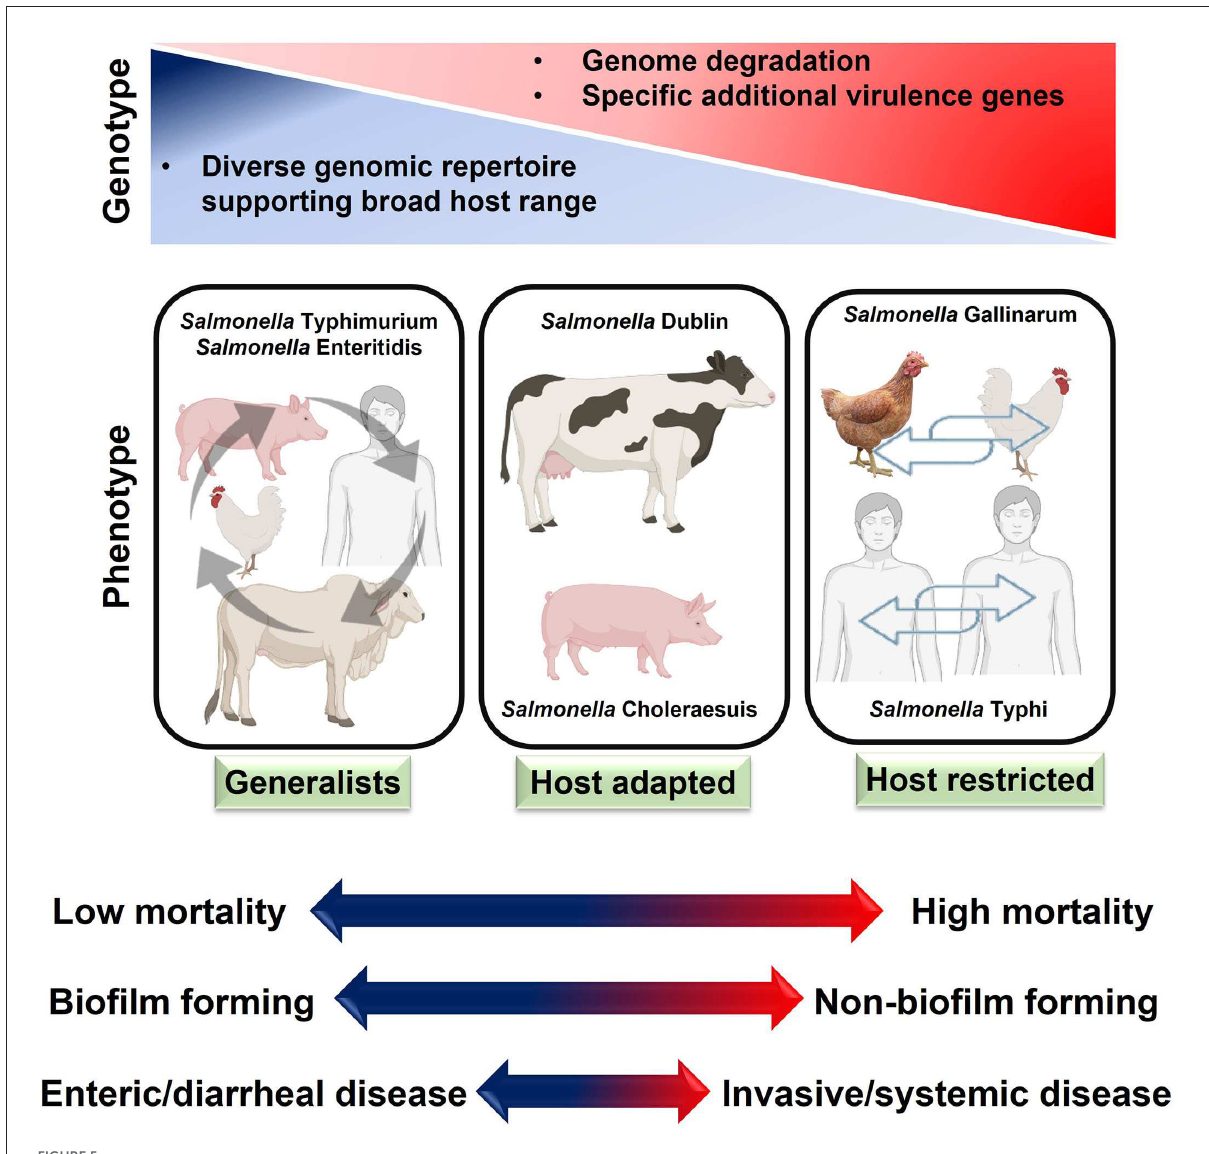
FIGURE5 Host adaptation of salmonellae and disease characteristics. Generally, host-restricted salmonellae cause more severe systemic diseases than host-adapted and generalists Salmonella